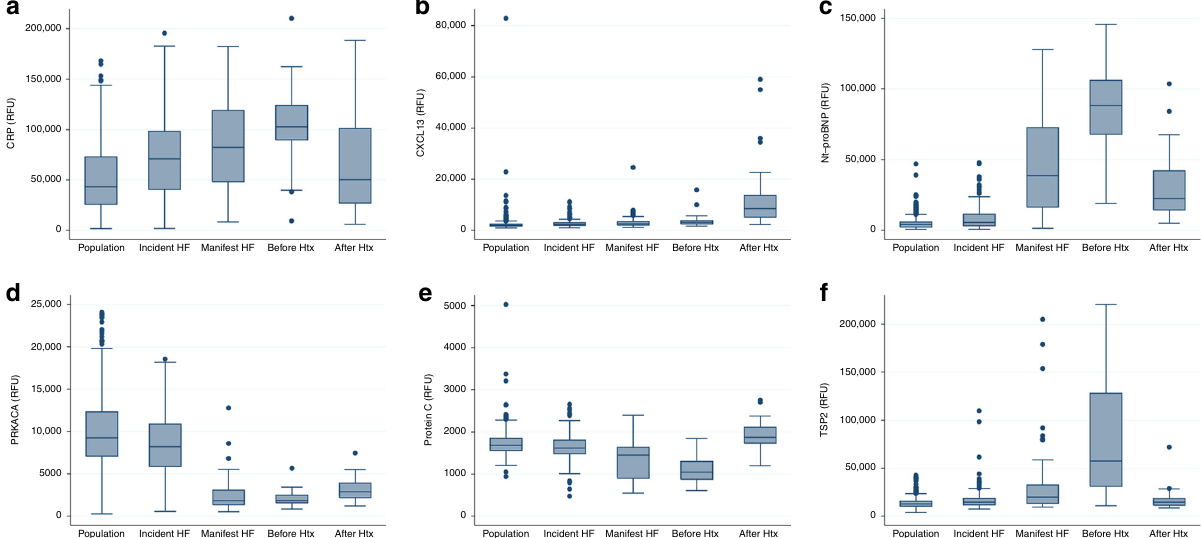
Fig. 2 Plasma protein abundance across heart failure stages. Box plots depicting distribution of ( a ) CRP, ( b ) CXCL13, ( c ) Nt-proBNP, ( d ) PRKACA, ( e ) Protein C, and ( f ) TSP2 across cohorts representing different stages of heart failure. In addition to association with incident heart failure, these six proteins changed markedly (>50%) after heart transplantation (HTx). Cohorts include individual human subjects from a population-based cohort who did not develop heart failure during follow-up ( “ Population ” , n = 583), from the population-based cohort who did develop heart failure ( “ Incident HF ” , n = 185), subjects with manifest heart failure ( “ Manifest HF ” , n = 84), and serial measures from subjects with advanced heart failure before and after heart transplantation ( “ Before Htx ” and “ After Htx ” , n = 30 for both). All except CXCL13 changed in directional consistency with the risk estimate for incident HF towards the general population. The box center line indicates the median, box bounds represent 25th and 75th percentiles, and the whiskers are the most extreme values within 1.5× the interquartile range from the nearer quartile. RFU relative fl uorescence units.